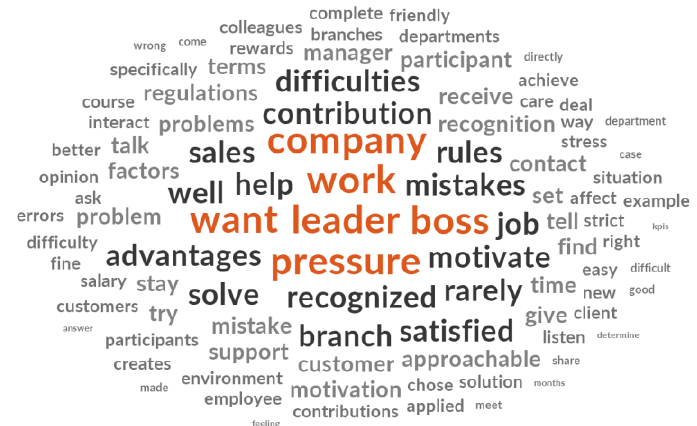
Figure 2. Word cloud.